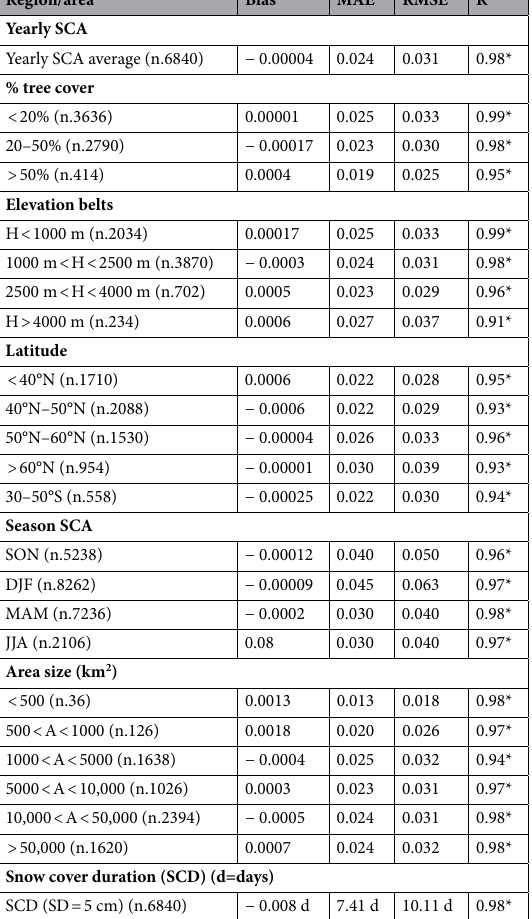
Table 3. Comparison between MODIS SCA and SCD and modeled FLDAS data after the downscaling procedure (*Pearson correlation significant at 5% level). For each data set, in parenthesis the number of points used in the evaluation is